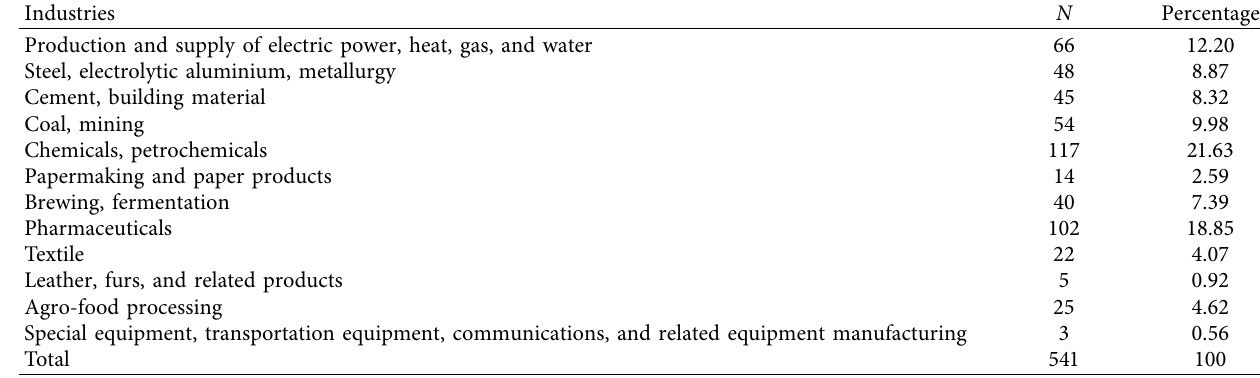
Table 1: Industry distribution of the sample firms.